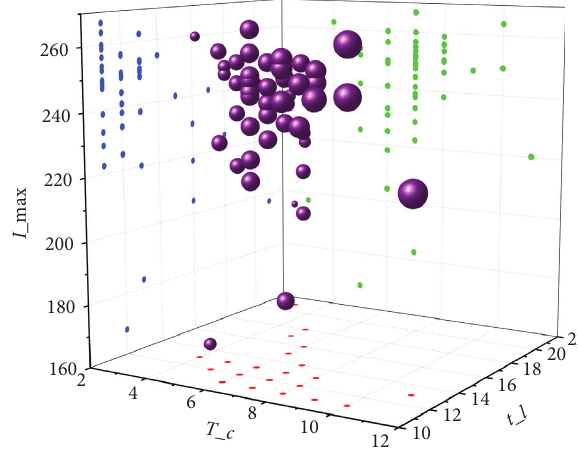
Figure 7: Communication frequency ( T _ C )-the start-up time of overlapping ( t _1) – revenue ( I _max).